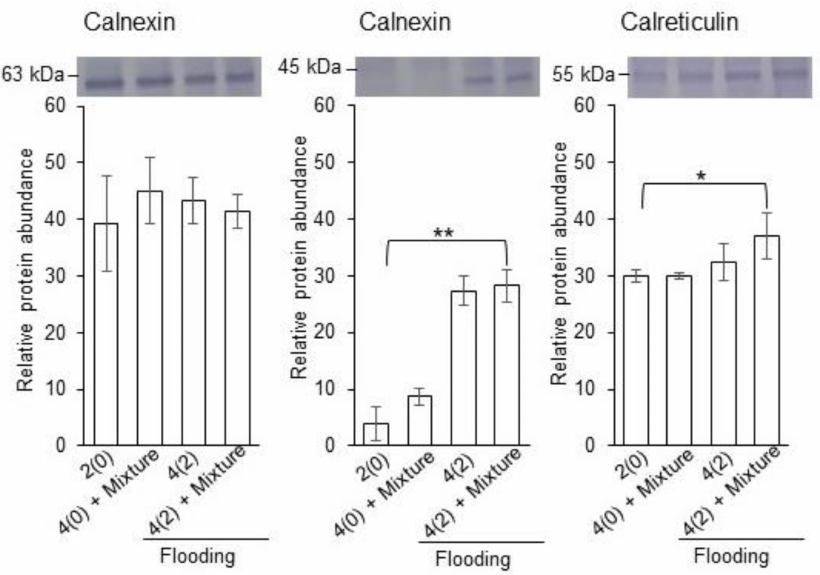
Figure 4. Accumulation of calnexin and calreticulin in soybean root under flooding with silver NPs / nicotinic acid / KNO 3 . Two-day-old soybeans were flooded with or without 5 ppm silver NPs / 8 µ M nicotinic acid / 0.1 mM KNO 3 for two days. Proteins (10 µ g) extracted from roots were applied to gel electrophoresis and immuno-blot was performed with anti-calnexin and anti-calreticulin antibodies. The integrated densities of bands were calculated using Image J software. Data are presented as the mean ± S.D. from three independent biological replicates. Significance was calculated using Students t -test (* p < 0.05, ** p <